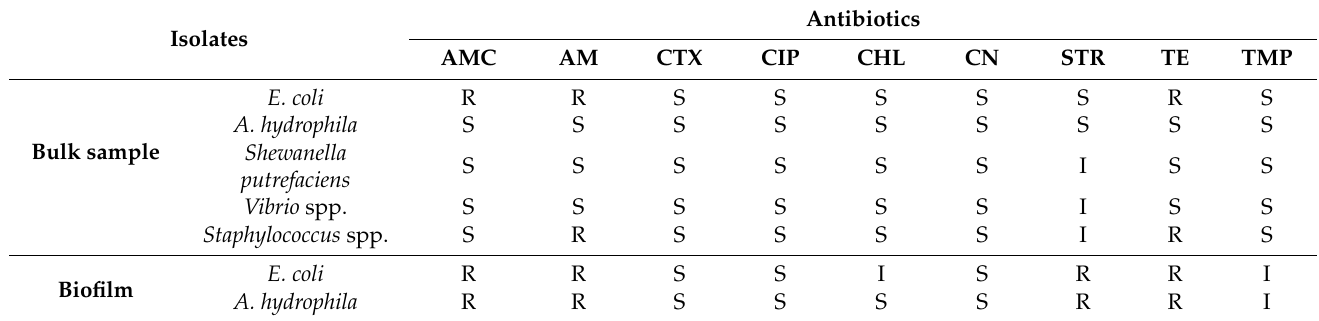
Table 4. Antibiotics susceptibility pattern of the isolates from grass